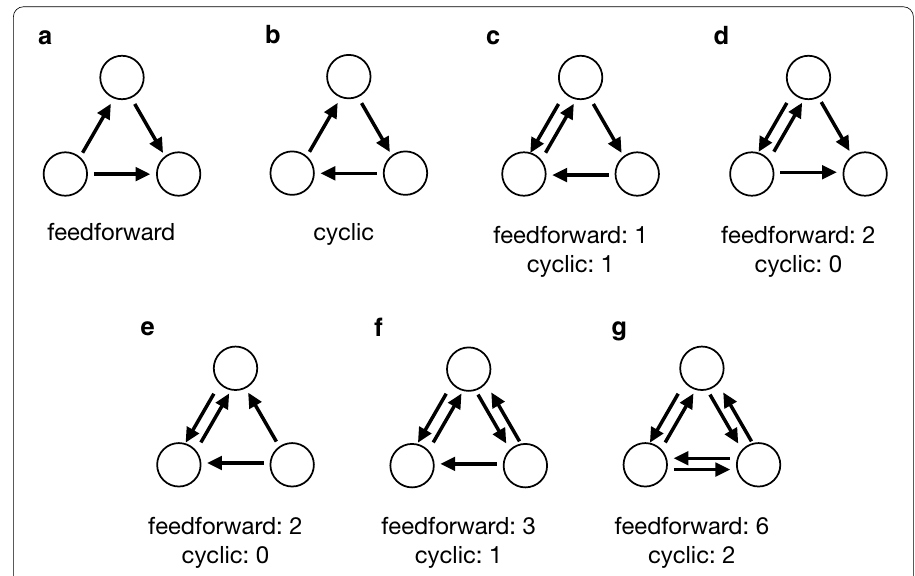
Fig. 2 Directed triangle patterns and their count. a Feedforward triangle. b Cyclic triangle. c – g Five three-node patterns that contain directed triangles and reciprocal edges. The numbers shown in the figure represent the number of feedforward or cyclic triangles to which each three-node pattern